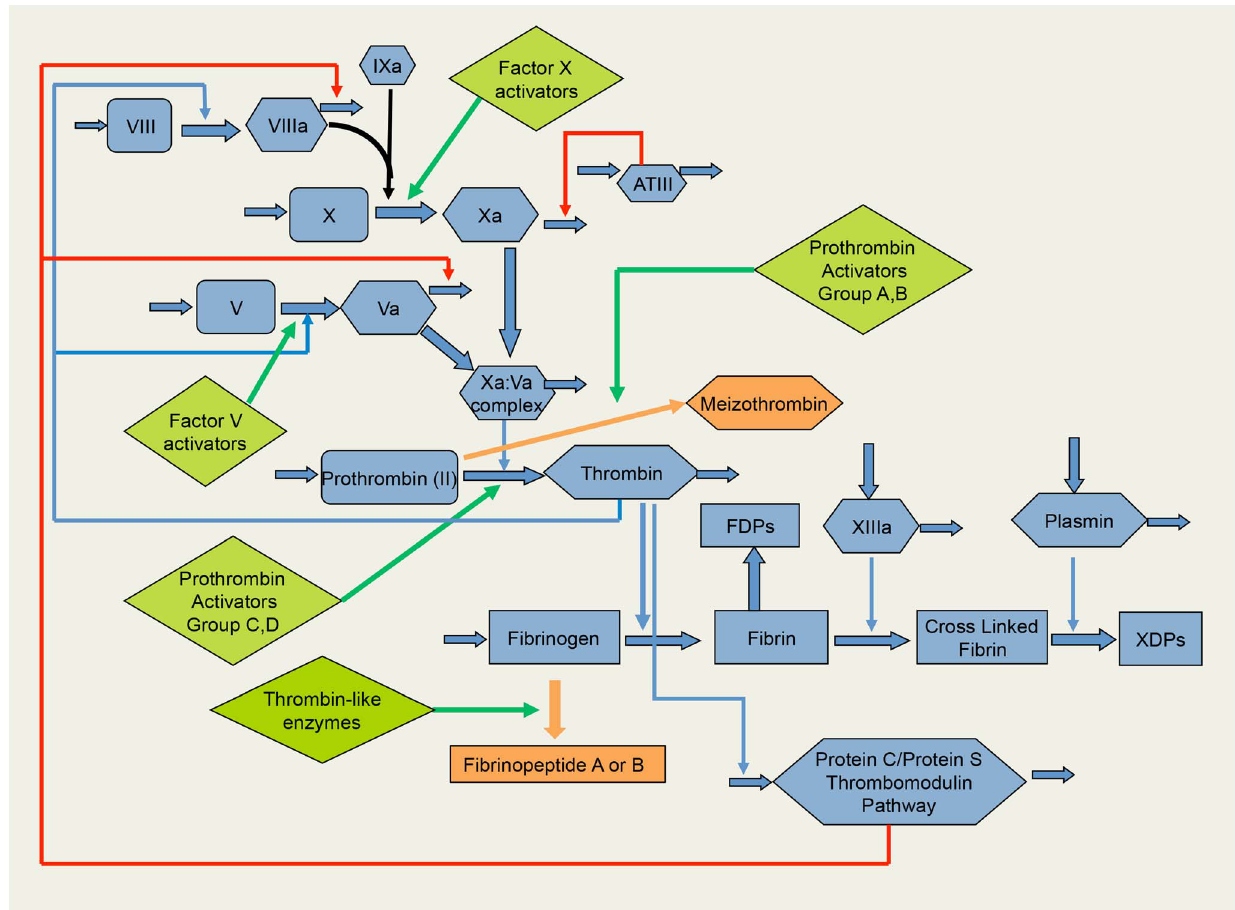
Figure 1. Diagram of the clotting pathway showing the major clotting factors (blue) and their role in the activation of the pathway and clot formation. The four major groups of snake toxins that activated the clotting pathway are in green and the intermediate or incomplete products they form are indicated in dark red. There are four major types of prothrombin activators, which either convert thrombin to form the catalytically active meizothrombin (Group A and B) or to thrombin (Group C and D).